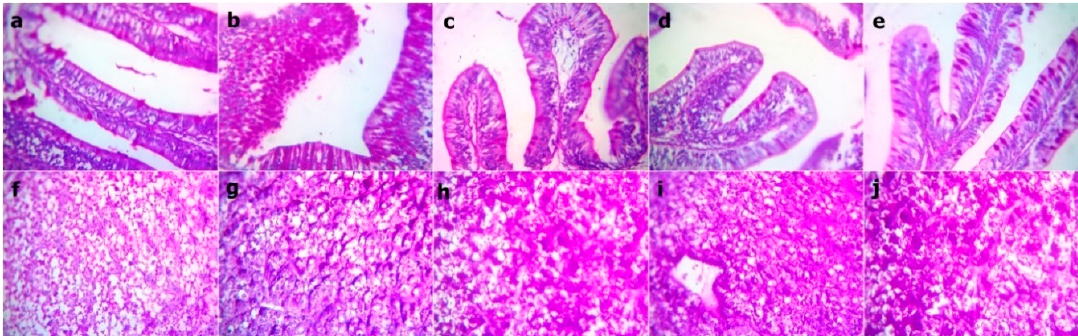
Figure 7 Representative photomicrograph of the Periodic Acid Schiff stained sections at magnification 400x from fish intestine and liver after bacterial challenge showing an increase in the red stainable intestinal goblet cells and mucous in WPC13.8 and within the limit no difference between the other groups. While, mild to moderate increase in the red granular stainable materials (glycogen) distributed in the hepatocyte cytoplasms in the WPC41.6 and WPC55.5 groups, while they are within the normal limit in the other liver sections. ( a , f , WPC0, ( b , g ) WPC13.8, ( c , h ) WPC27.7, ( d , i ) WPC41.6, ( e , j ) WPC55.5.